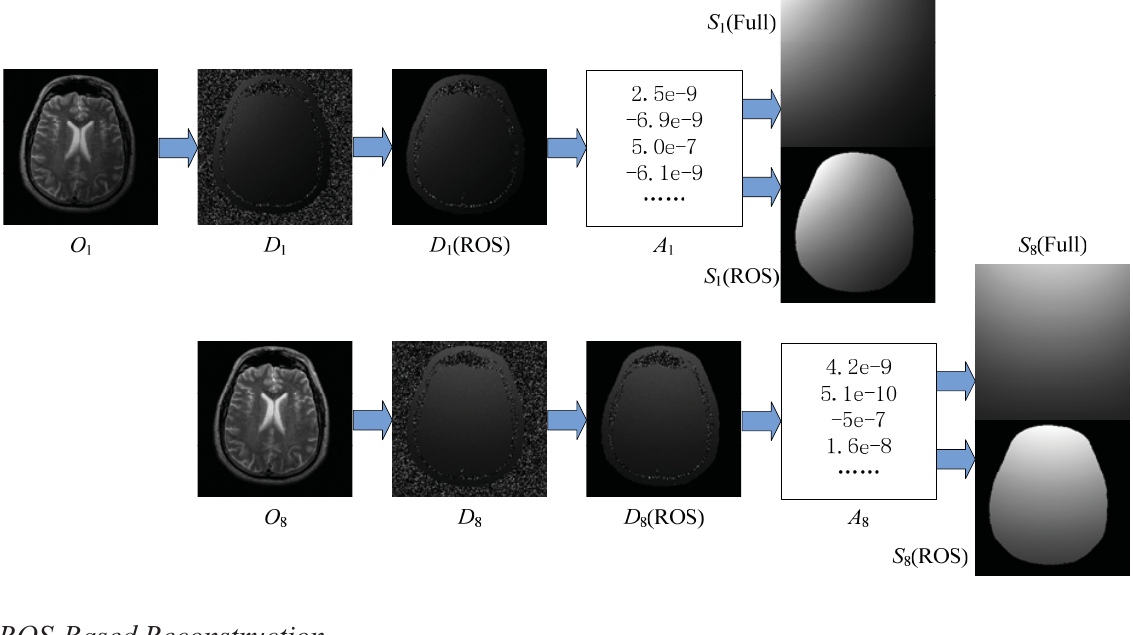
Figure 4. Estimation of sensitivity maps. From left to right columns: eight scout images to O ) from eight channels; energy ratios (D (O 1 8 parameters by Equation (10); the estimated sensitivity maps S full